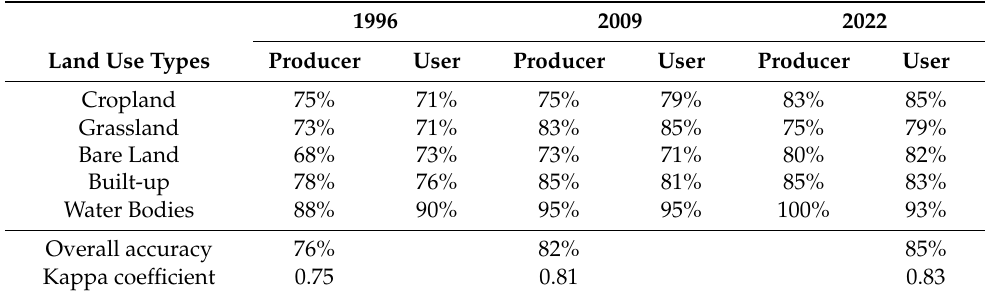
Table 3. Confusion matrix for classified